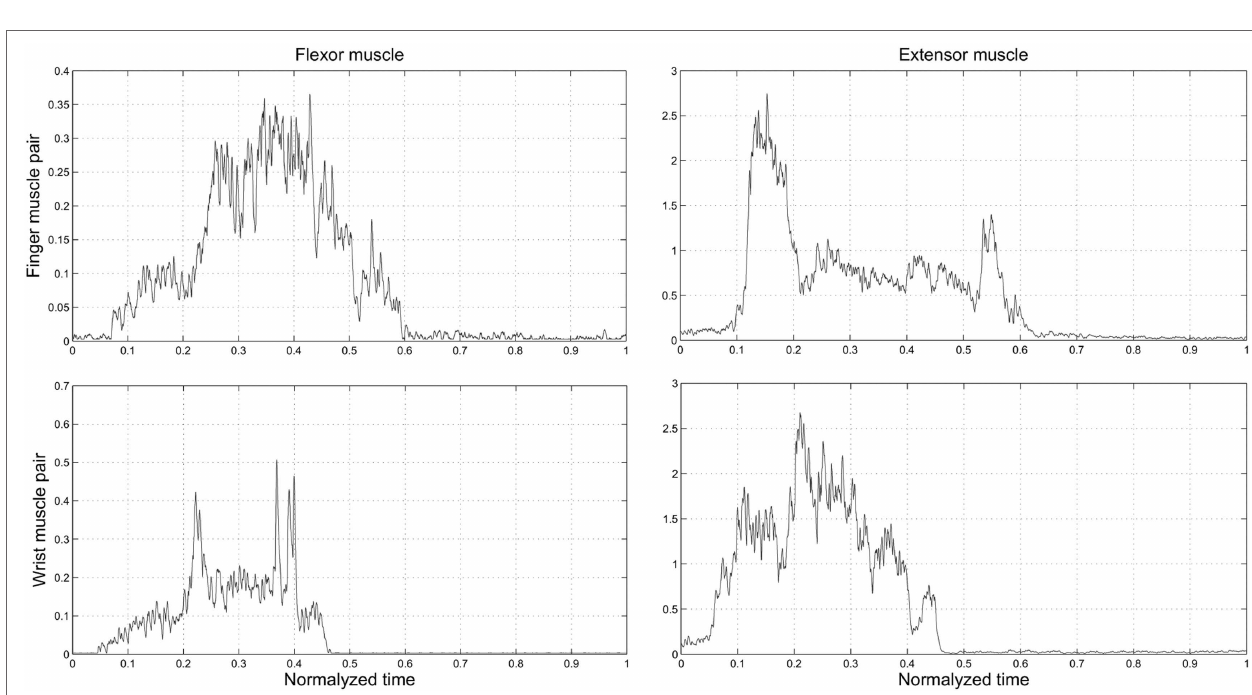
FIGURE 8 | Experiment 2 : time course of EMG activity from finger and wrist muscles (top and bottom row, respectively) as a function of normalized time on the trial duration . “0” and “1” denote the starting moment of the movement of reach and the end of the trial within the predefined time, when the hand was back in starting position,